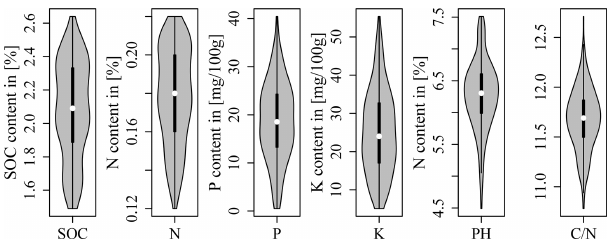
Figure 1. Soil archive data of the LTFE measured from 2004 to 2007 (reports of the experimental station Bad Lauchstädt 2004– 2007; unpublished